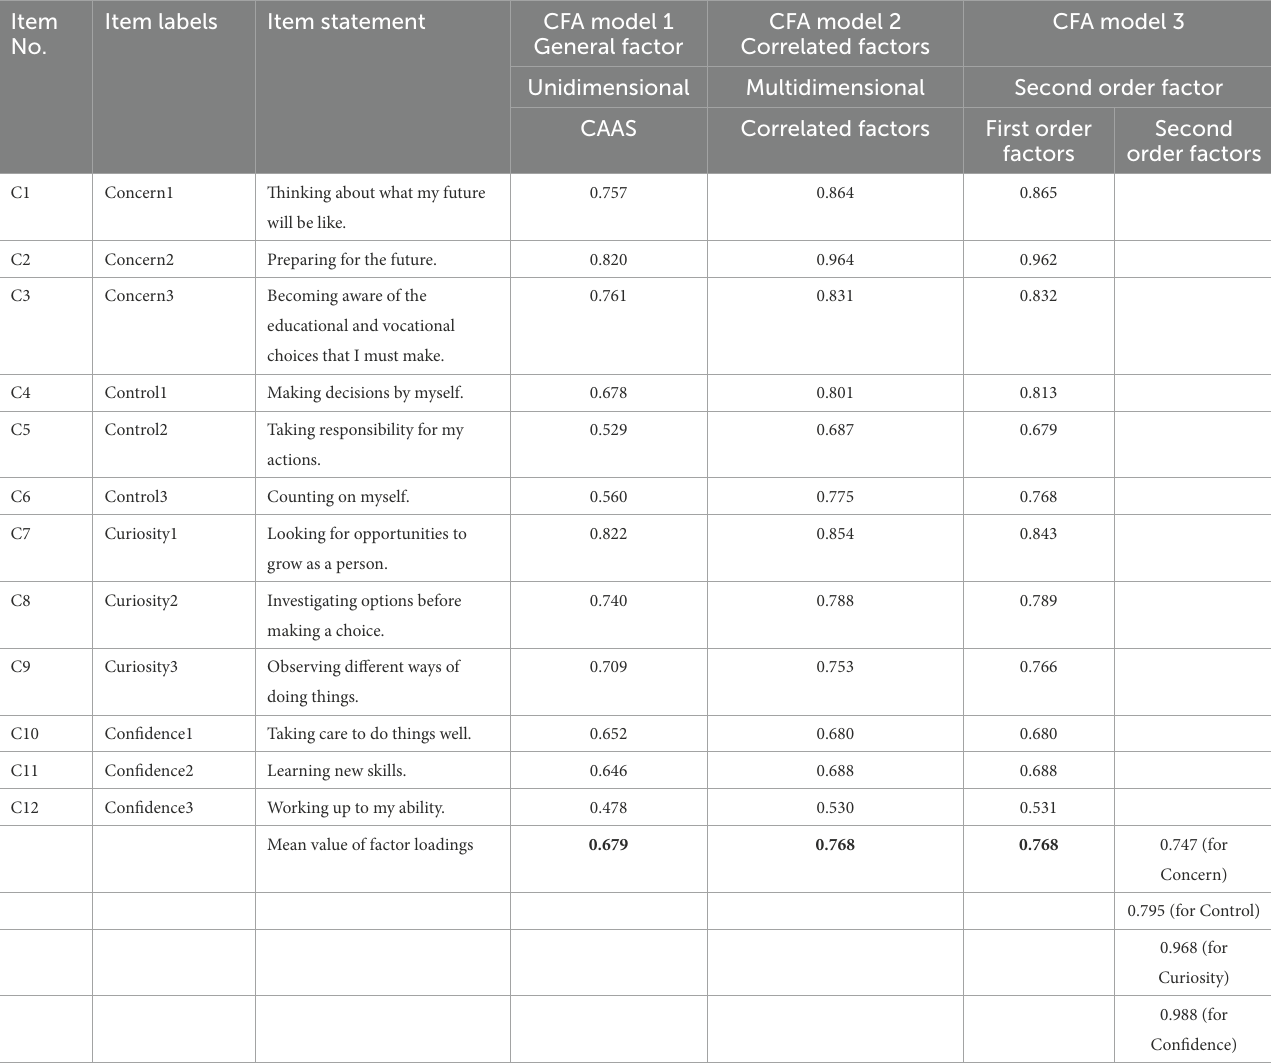
TABLE 3 Standardized factors loadings of the three alternative models. Item